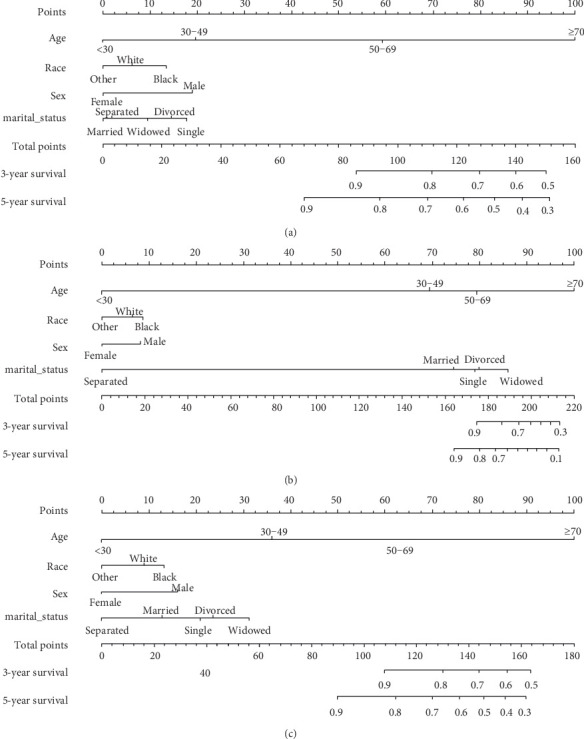
A nomogram including the variables independently related to survival is shown. (a) Variables independently related to survival in group 1992-2001; (b) variables independently related to survival in group 2002-2011; (c) variables independently related to survival in group 1992-2011.